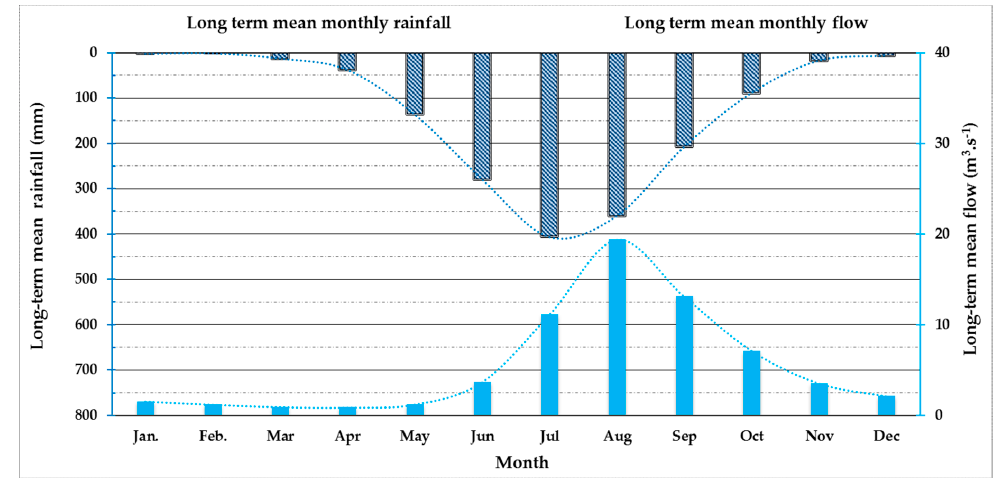
Figure 3. Catchment long-term mean monthly rainfall and streamflow (1989–2007).